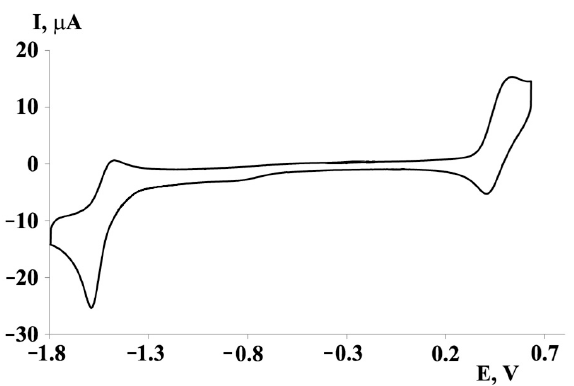
Figure 6. Cyclic voltammogram of 5 the potential switch from 0.63 to -1.80 V (CH 2 Cl 2 , C = 2 mmol, 0.1 M TBAP, scan rate 200 mV ∙ s − 1 ).